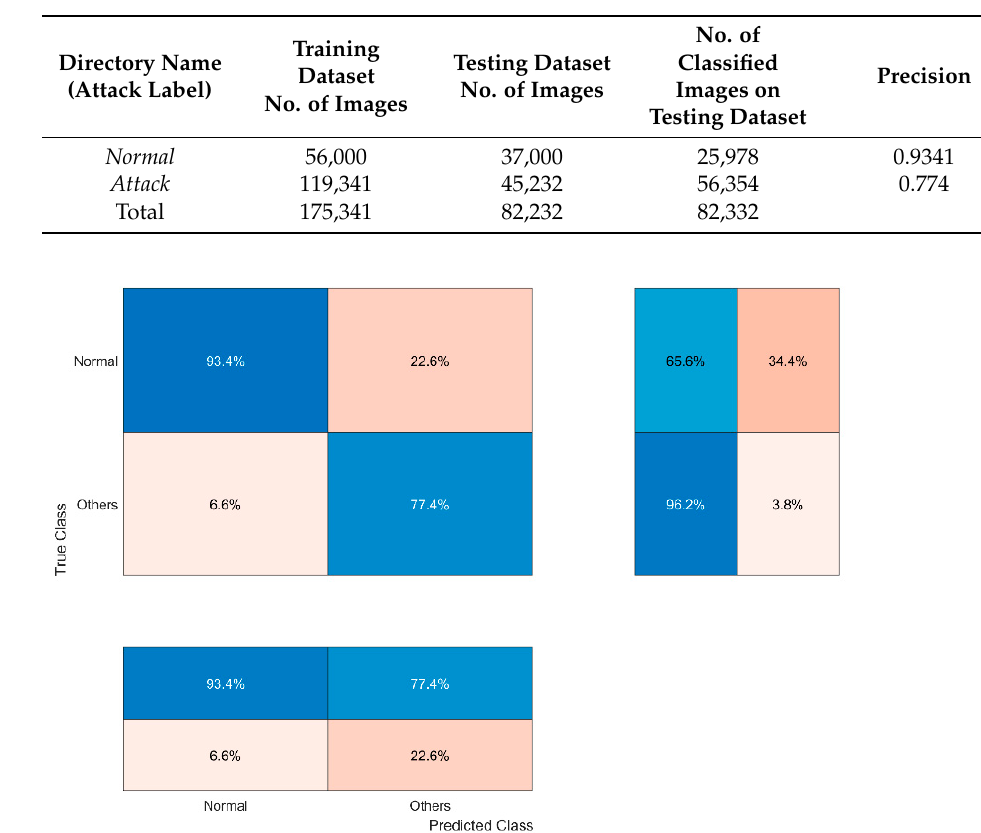
Figure 11. ROC curve of the first stage using ML.NET created model on UNSW-NB15 training dataset employing binary classification. 4.2.4. Attack Type Recognition on UNSW-NB15 Dataset After Attack Was Detected In the fourth scenario for the UNSW-NB15 dataset, we use our proposed normaliza- tion rule (see Section 3.2) and NTF transformation into ARGB images with a width of 42 pixels and height of 1 pixel (W42 × H1), taking into account that an attack was detected and attack type recognition is needed. Based on the empirical results presented in Section 4.2.3, images that were recognized as an attack proceeded to the second stage for recognition and attack type detection. Our experimental results (see Table 7) show that when detecting a concrete type of attack, the precision of image classification on the testing dataset when the ML.NET model was cre- ated on the UNSW-NB15 training dataset is very high for generic attack (99.8%) traffic features. Other types of attack are difficult for recognition; only for Reconnaissance (86%)